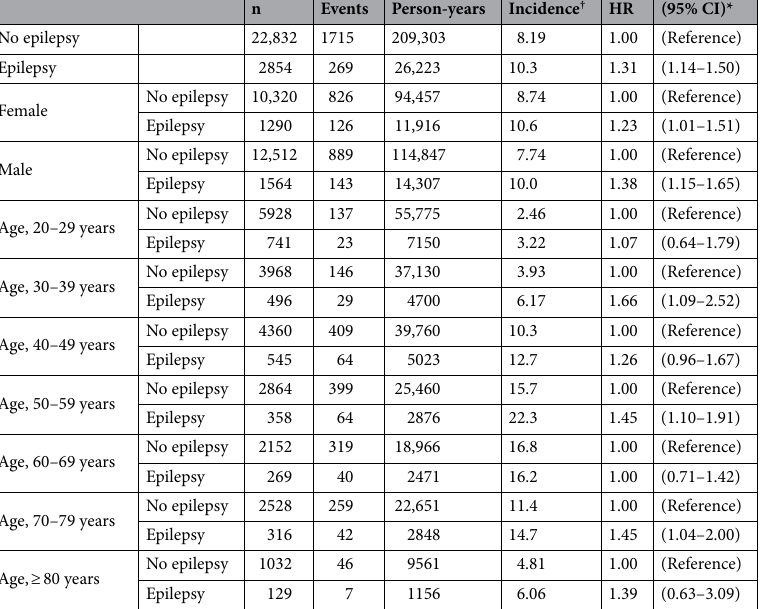
Table 2. Risk of diabetes in association with epilepsy stratified by age and sex. CI confidence interval, HR hazard ratio. *Adjusted for all covariates listed in Table 1. † Per 1000 person-years.